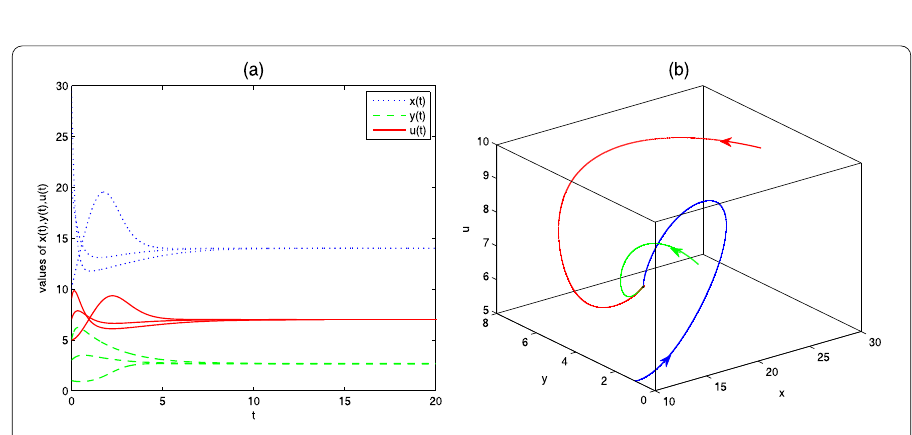
Figure 4 Global asymptotic stability of the positive equilibrium point E 2 for different initial